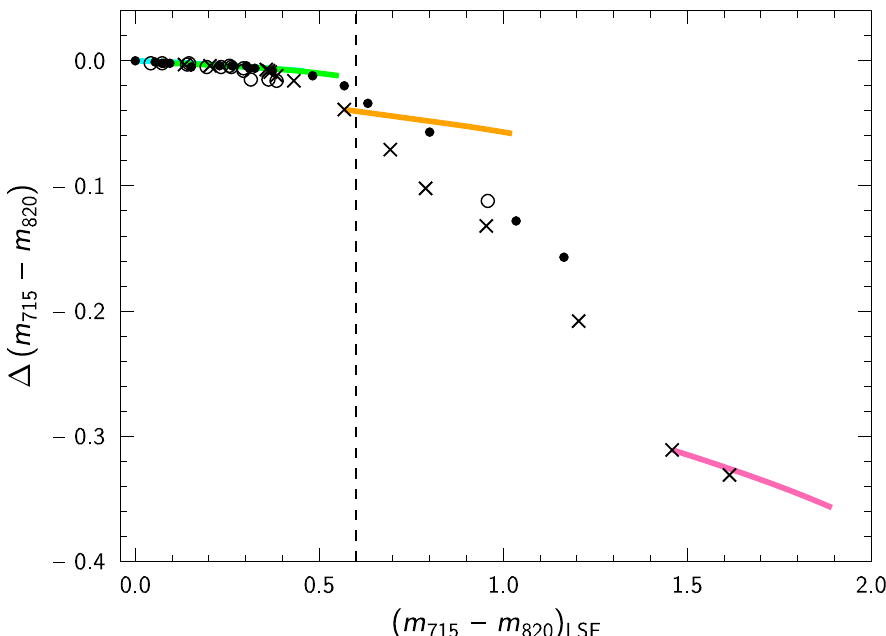
Fig. 10b. The same as in Figure 10a but for the color index m 715 – m 820